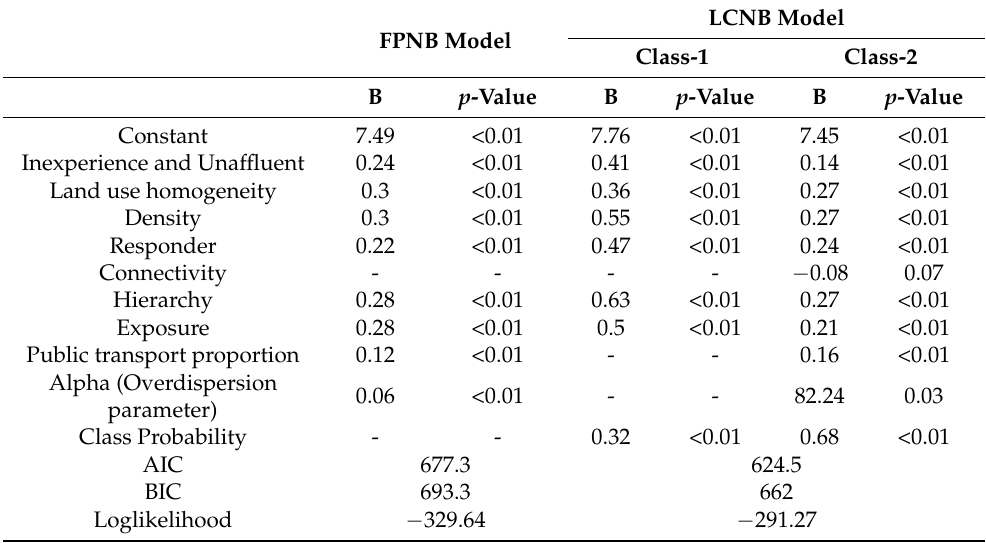
Table 4. Crash frequency model estimation